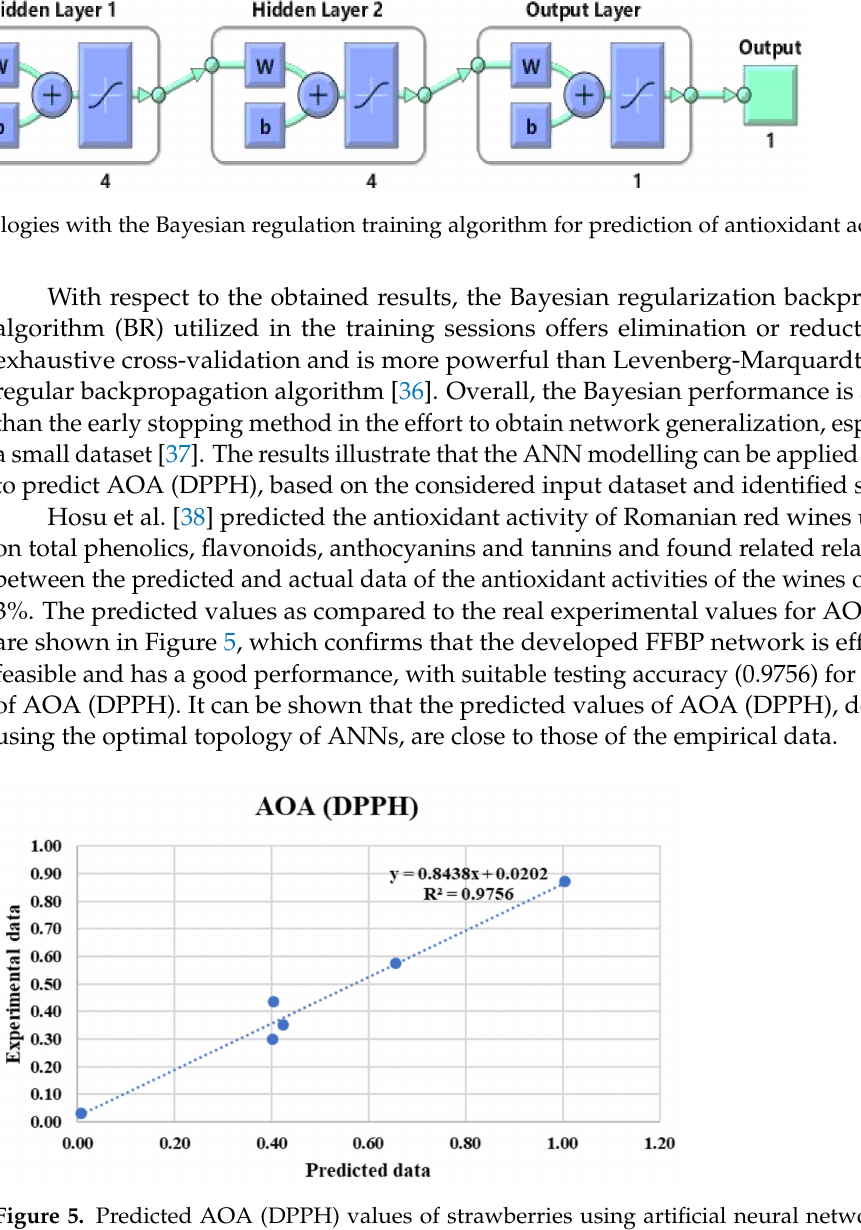
Figure 5. Predicted AOA (DPPH) values of strawberries using artificial neural networks versus experimental values for testing